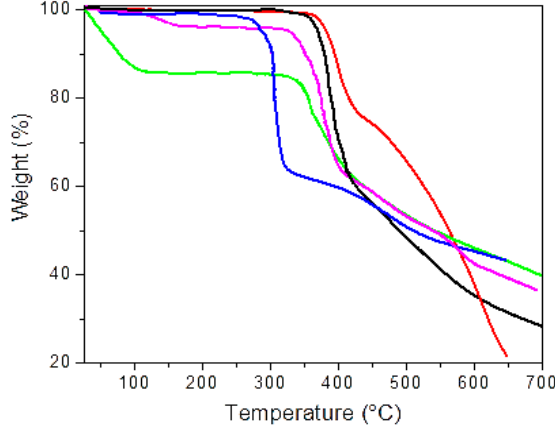
Figure 2. Thermogravimetric analysis (TGA) traces of [Zn(tr 2 ad)Cl 2 ] n (black), {[Cu(tr 2 ad)Cl]Cl ∙ 4H 2 O} n (green), [Cd 2 (tr 2 ad)Cl 4 ] n (red), {[Cu(tr 2 ad)(NO 3 )](NO 3 )} n (blue) and {[Cd(tr 2 ad)(NO 3 )](NO 3 ) ∙ H 2 O} n (fuchsia).